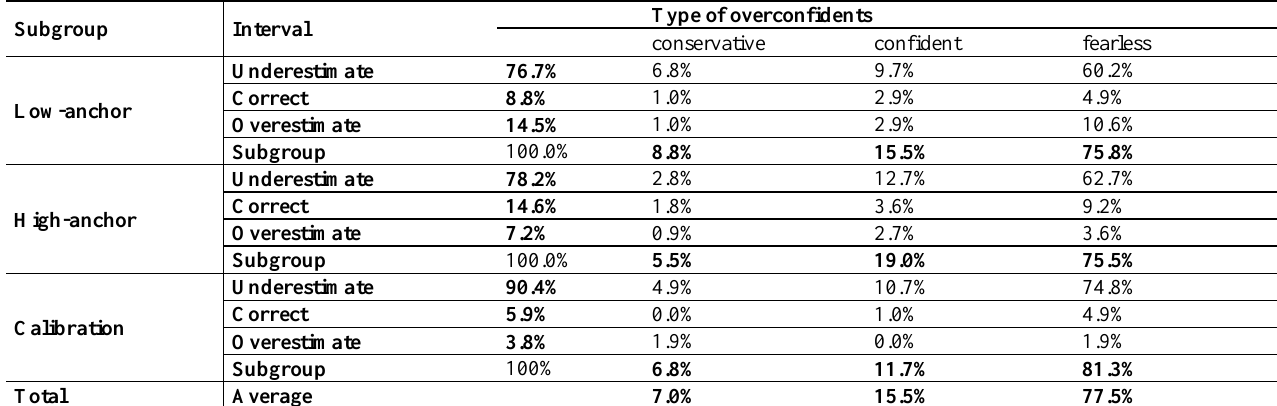
Table 9: Estimates of life expectancy